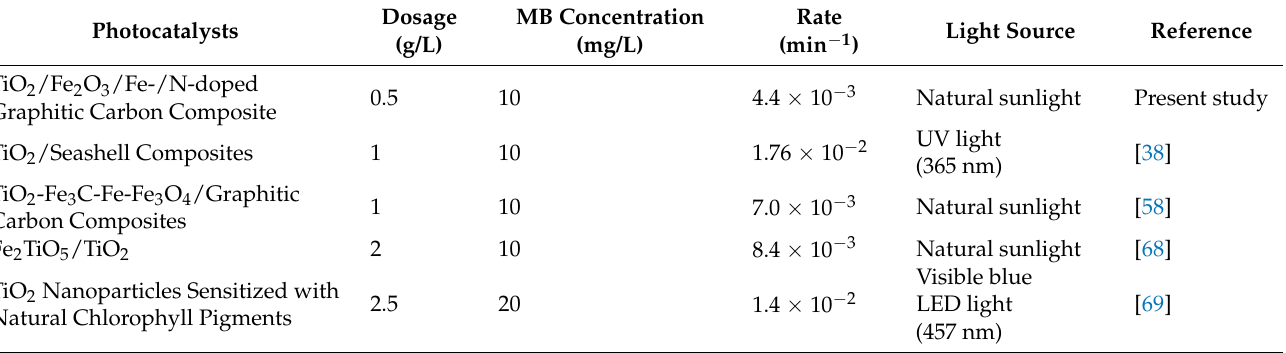
Table 8. A comparison of the rate constant respective to the other parameters in different